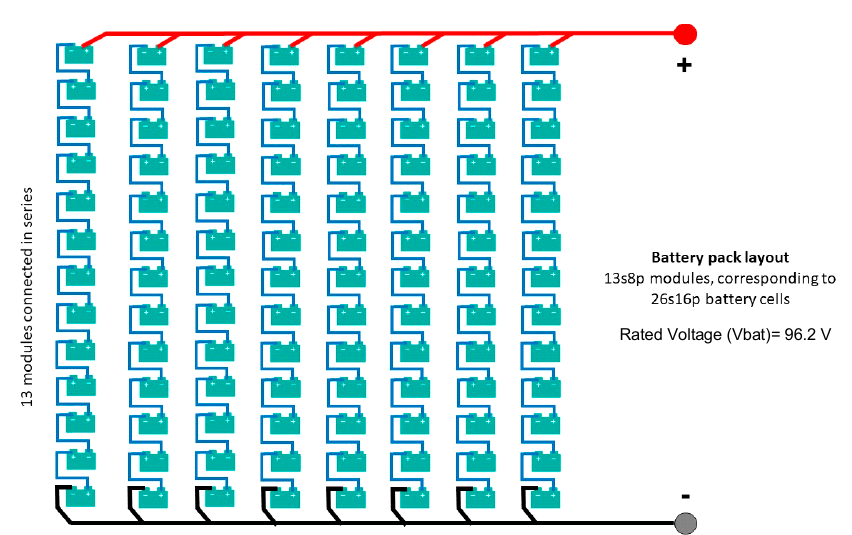
Figure 3. Battery-pack electric layout.